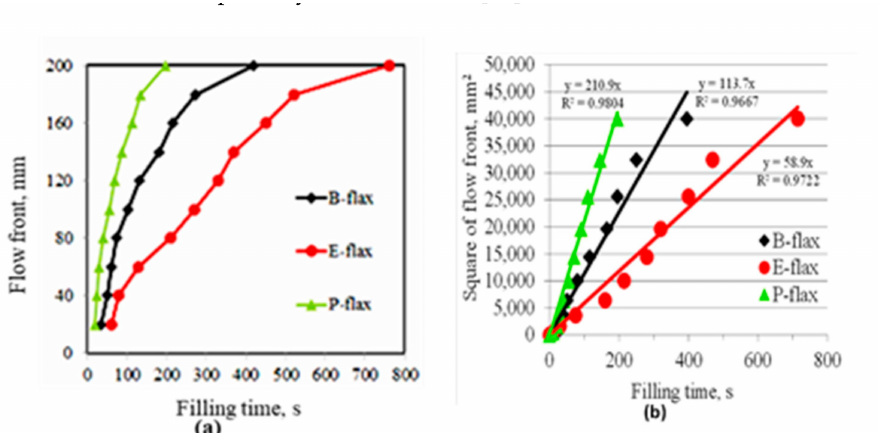
Figure 4. ( a ) Flow front (mm) versus filling time (s) and ( b ) square of flow front (mm 2 ) versus filling time (s) of cross-laminated flax tape impregnated with three di ff erent resin systems. The slope of the graph x 2 / t (right) can be used as an input in Equation (1) to determine K unsat for the flax tape